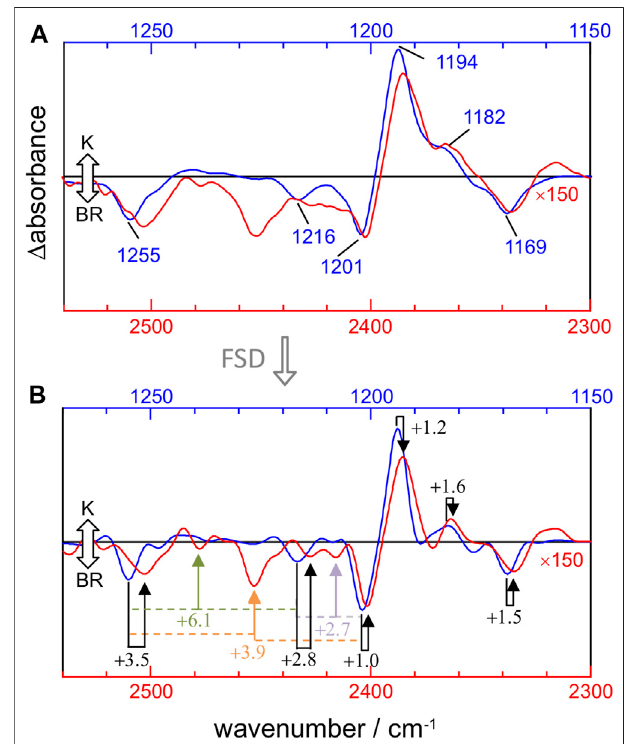
FIGURE 4 | Comparison between ν C-C fundamentals (blue traces) and ν C-C overtones (red traces) in the K-BR spectrum (A) Experimental K-BR difference FT-IR spectrum in the 1,275 – 1,150 cm − 1 (blue) and 2,550 – 2,300 cm − 1 (red) region. Wavenumbers of bands from fundamental transitions are indicated (see Table 1 for their assignments). (B) Band-narrowed K-BR spectrum using a narrowing factor of 1.6 and a Lorentzian width of 7 cm − 1 for the 1,275 – 1,150 cm − 1 region and of 14 cm − 1 for the 2,550 – 2,300 cm − 1 region. Overtone bands are labelled with their estimated mechanical anharmonic constant (black) and combination bands withtheirmechanicalcouplingconstant(color)constants(see Table2 fortheir assignments). Note that in both (A) and (B) the overtone region is scaled by